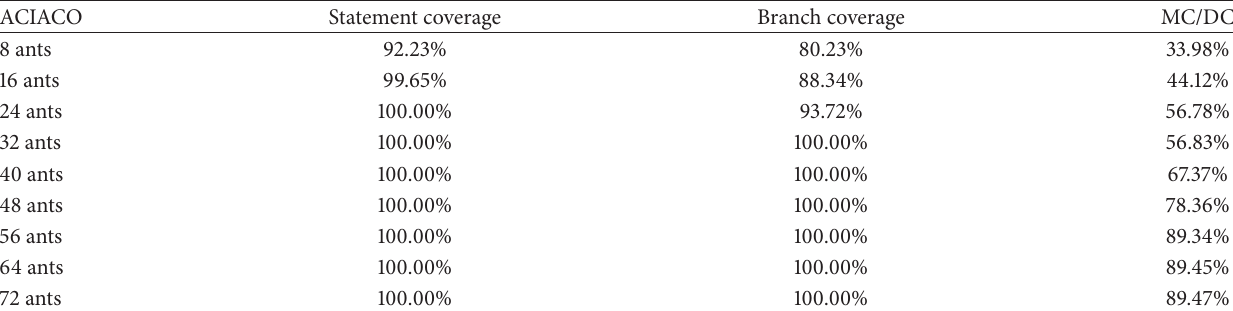
Table 3: The coverage of different ant numbers on ACIACO.